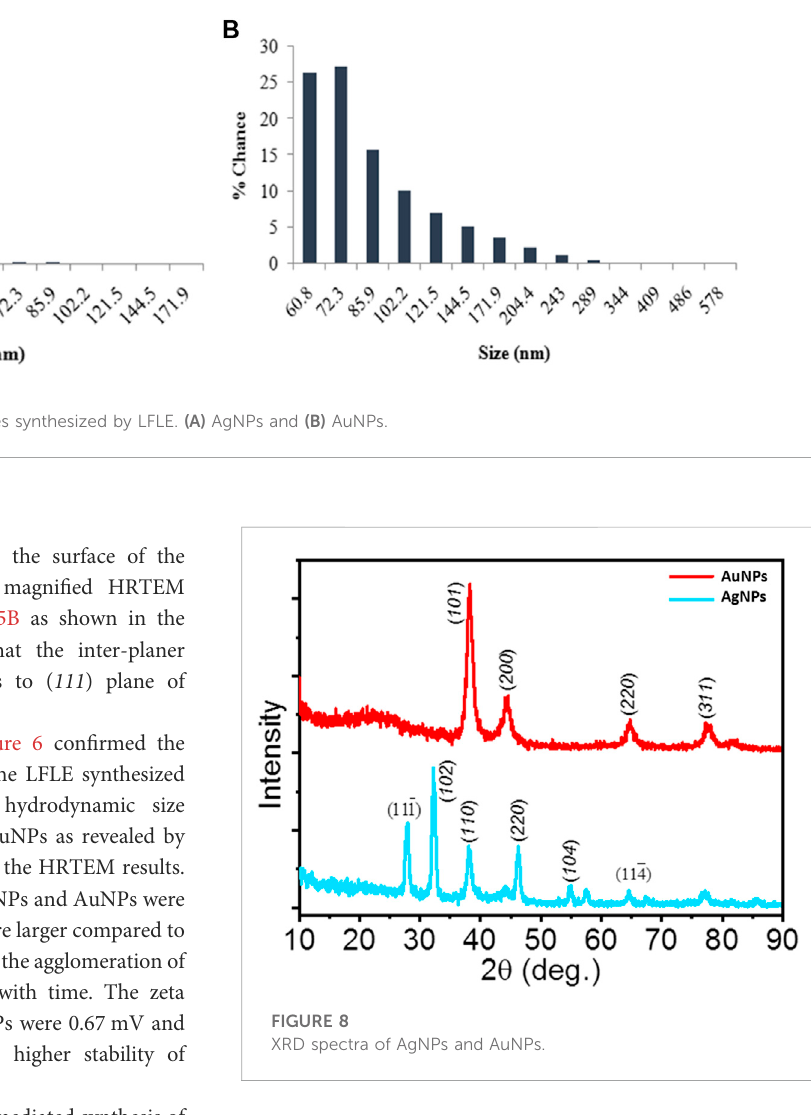
peaks at 2 θ value of 27.90 ° , 32.30 ° , 38.10 ° , 46.30 ° , 54.90 ° , and 64.40 ° corresponding to ( 111 ) , ( 102 ), ( 110 ), ( 220 ), ( 104 ), and ( 114 ) planes of silver, respectively. Likewise, the XRD spectrum of AuNPs reveal a large number of peaks at 2 θ value of 38.10 ° , 44.30 ° , 64.70 ° , and 77.40 ° corresponding to ( 101 ), ( 200 ), ( 220 ), and ( 311 ) planes of gold, respectively.